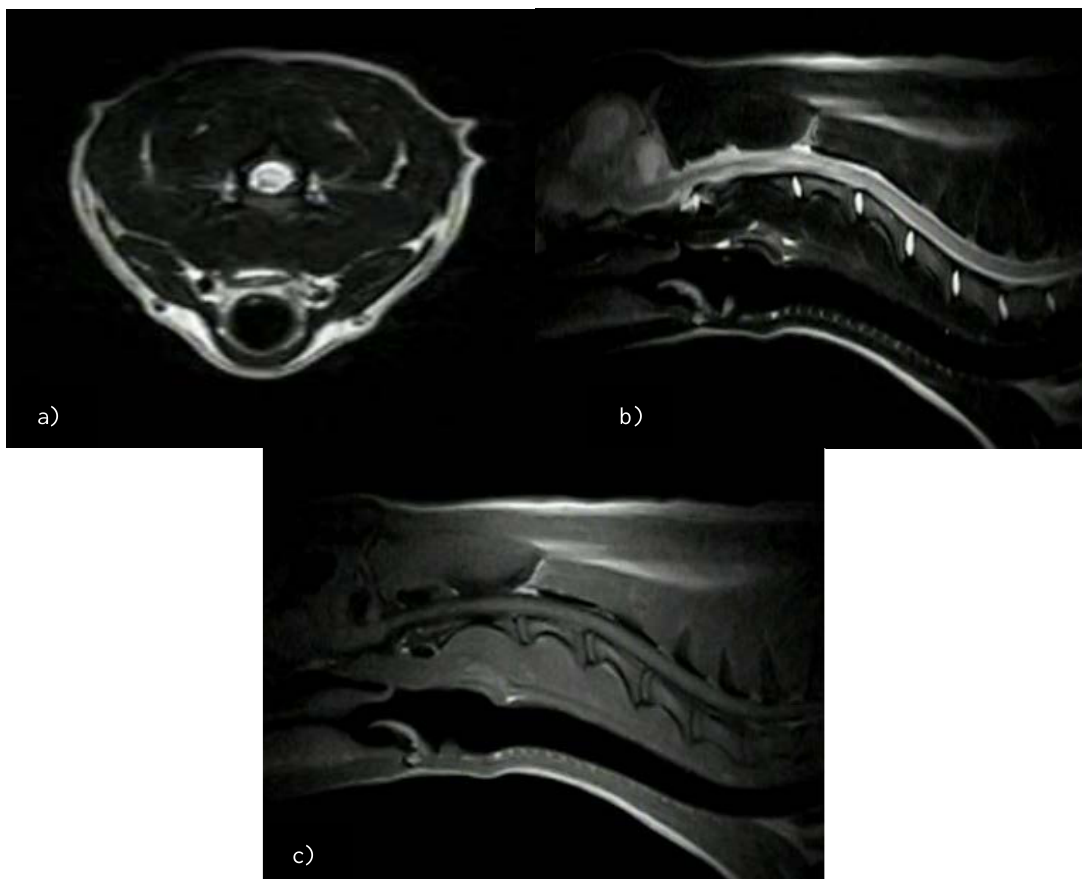
Fig. 1. Magnetic resonance imaging of the dog's spinal cord at the level of 2–3 cervical vertebrae with manifestations of traumatic myelitis/hematomyelia (24 hours after